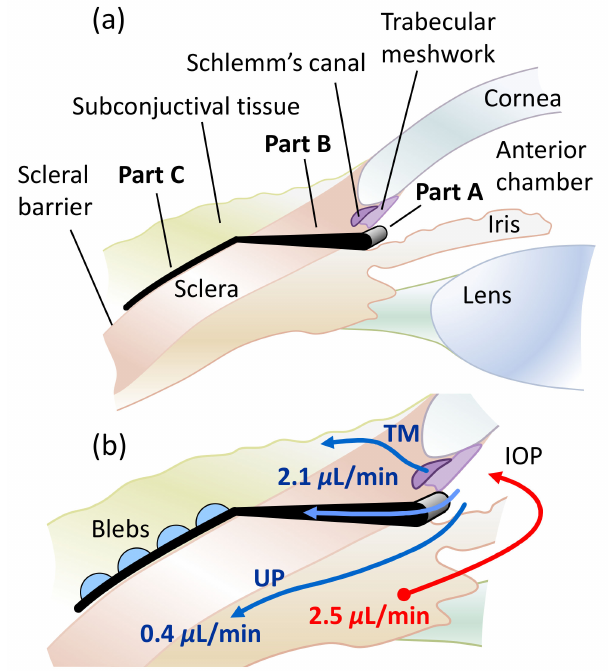
Figure 1. ( a ) Sectional anatomy of the eye with glaucoma stent. Part A is placed in the anterior chamber to collect AH. Part B conducts the AH into the meshwork of part C. Part C drains the fluid into the subconjunctival tissue. ( b ) Drainage pathways and flow balance in the eye after surgery. AH is produced in the ciliary body and drained by the trabecular meshwork (TM) via Schlemm’s Canal, the uveoscleral pathway (UP) and the stent. At the stent outlets, blebs form in the subconjunctiva on the scleral barrier. The indicated flow rates were used in numerical simulation.